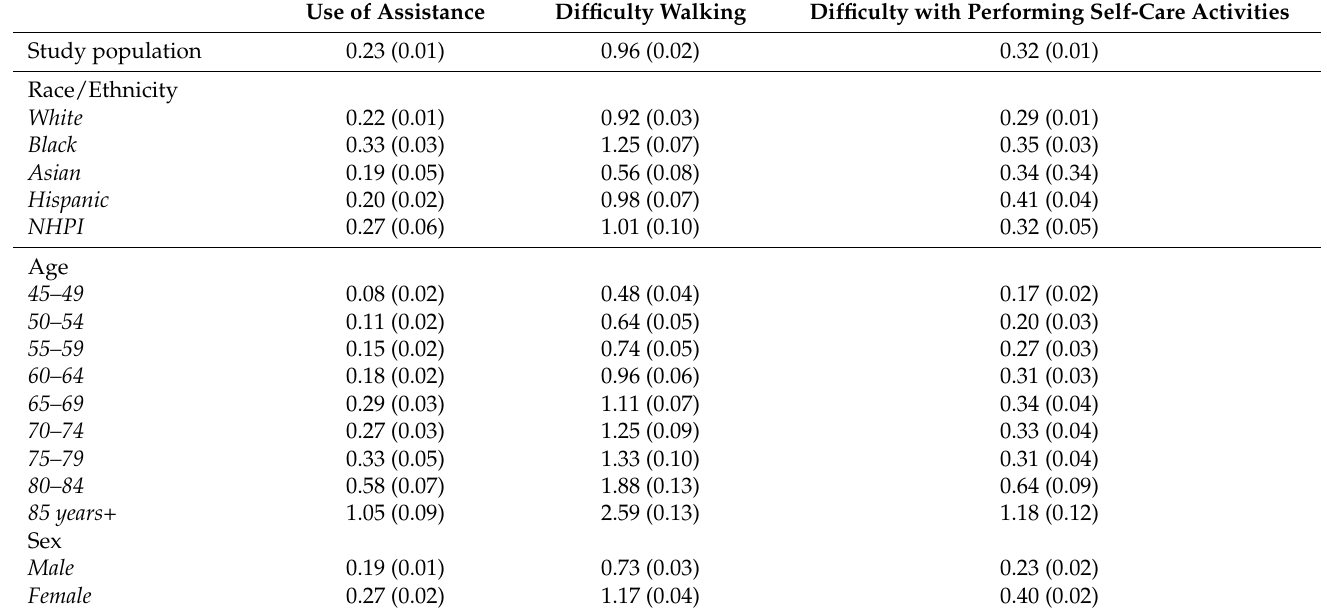
Table 2. Functional Limitation Distribution across Race/Ethnicity, Age, and Sex.